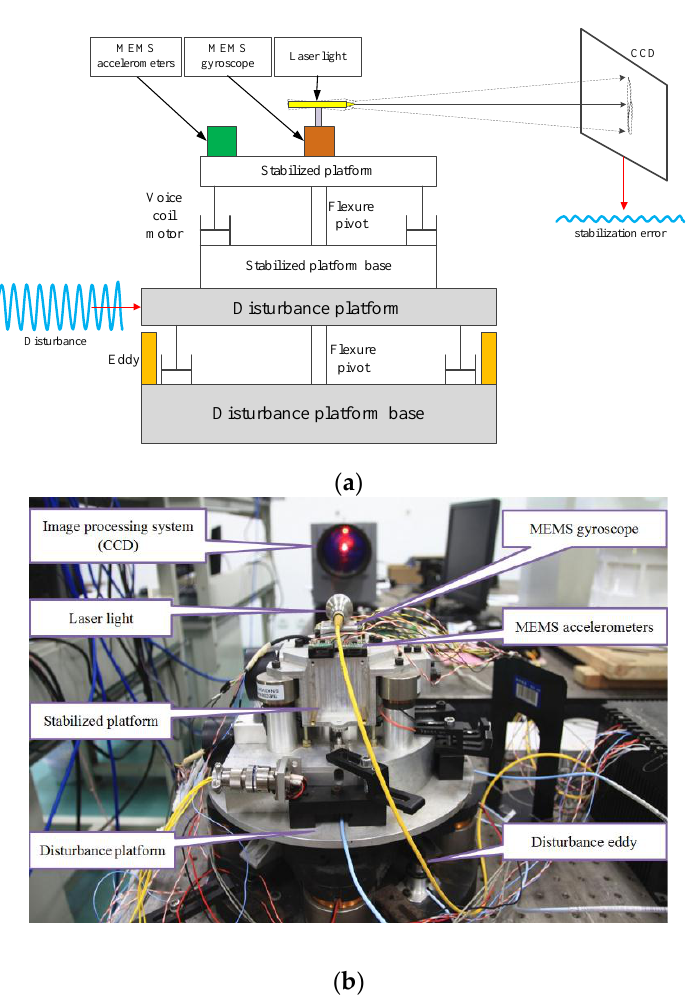
Figure 9. Experimental apparatus. ( a ) Principle of apparatus; and ( b ) Prototype of apparatus.